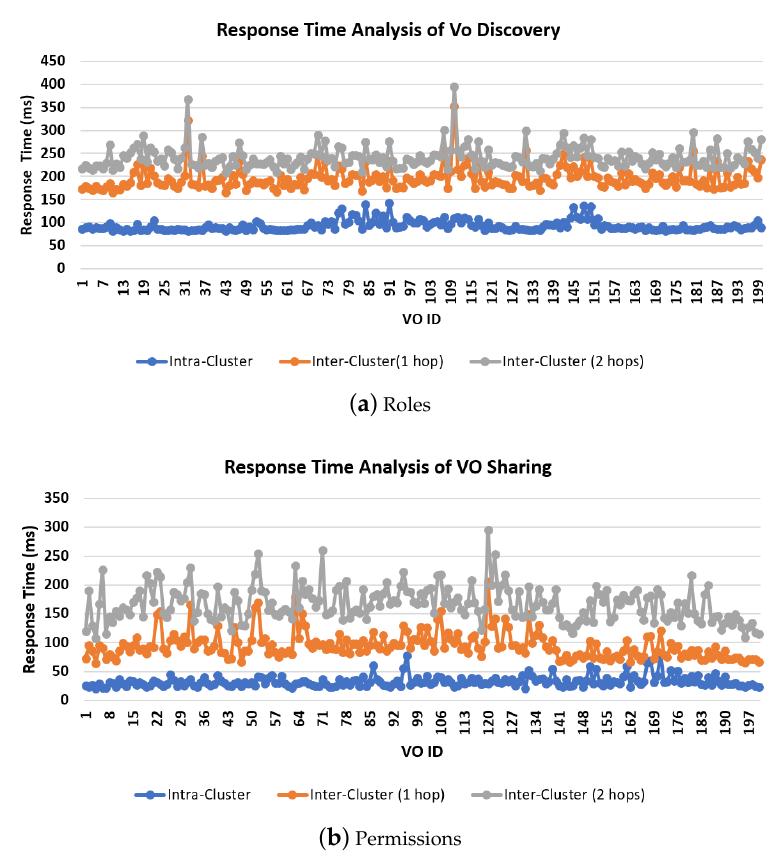
Figure 20. Response time analysis of application store access.